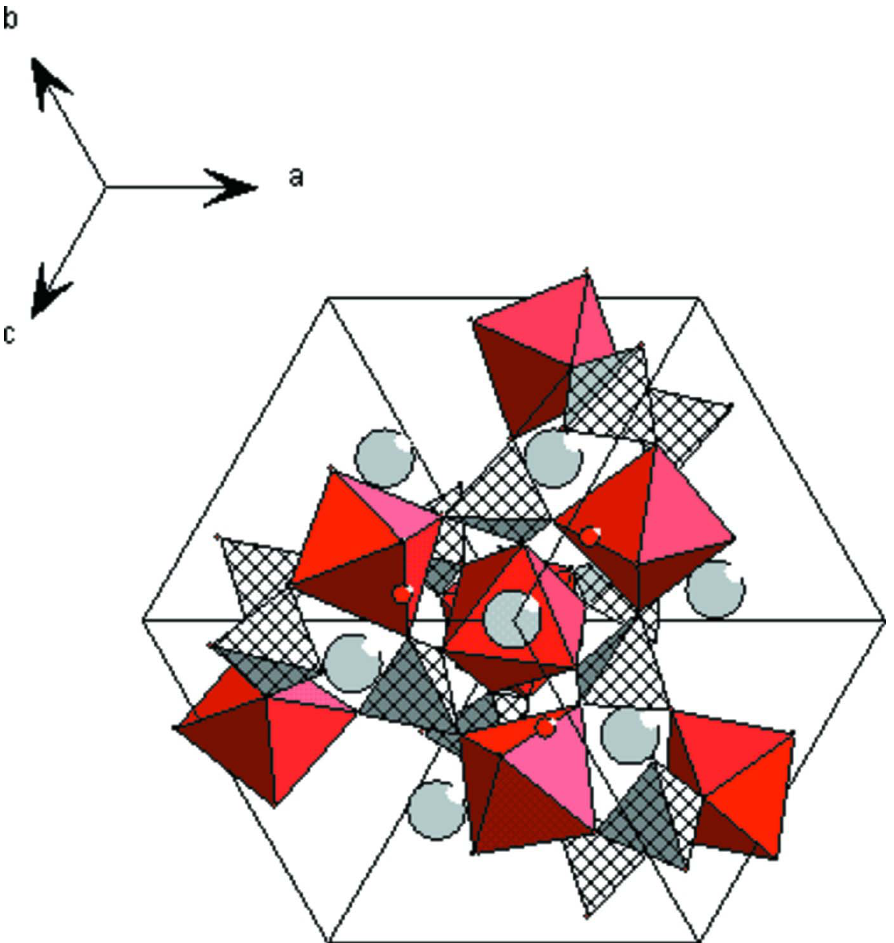
A projection of the structure along the [111]